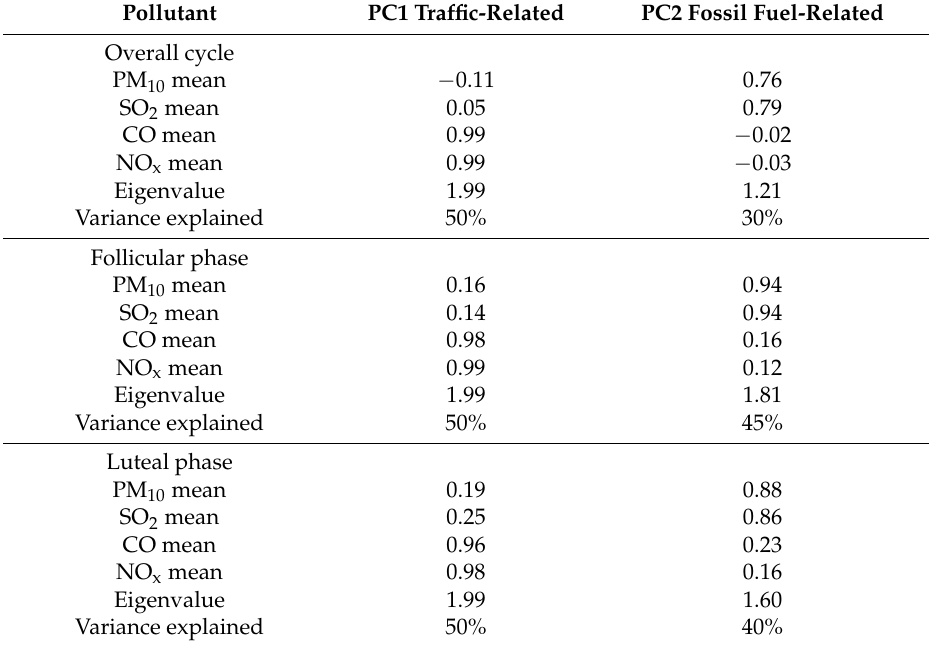
Table 3. Factor loadings after Varimax rotation of mean levels of pollutants measured during menstrual cycles (overall menstrual cycle, follicular, and luteal